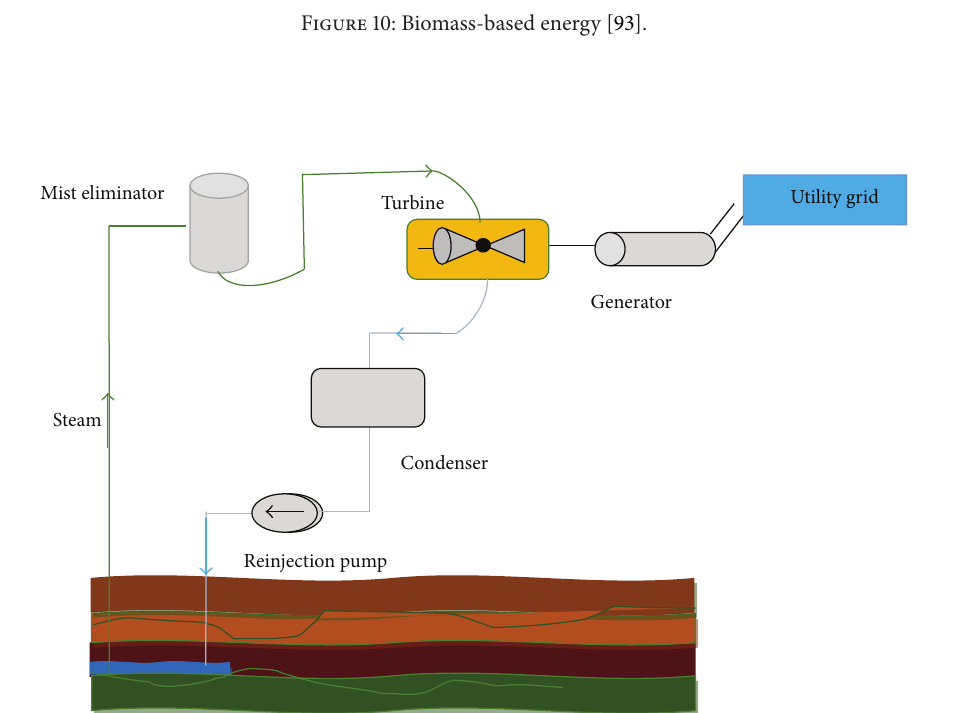
Figure 11: Geothermal-based power generation